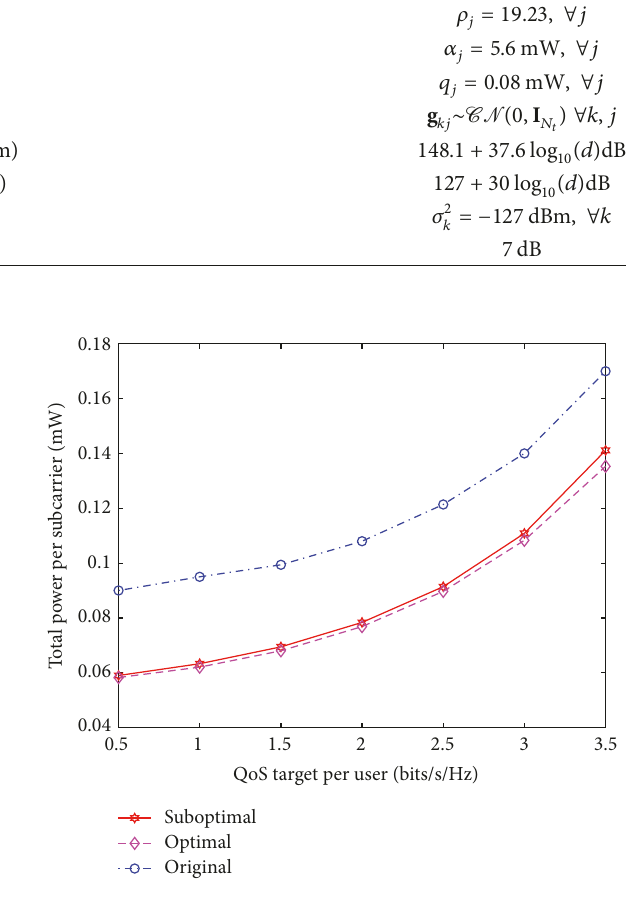
Figure 4: Total power consumption versus QoS target per